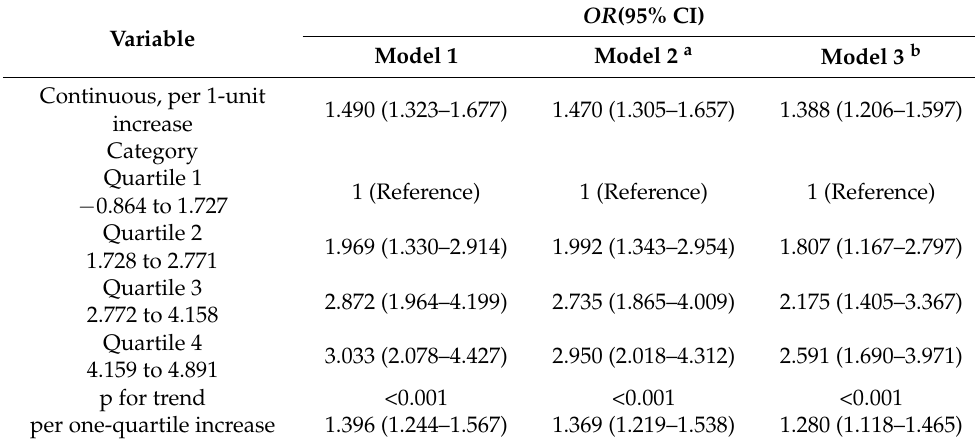
Table 3. Adjusted Odds Ratios (OR) and 95% Confidence Intervals (CI) for the Association Between DII and Esophageal Squamous Cell Cancer.